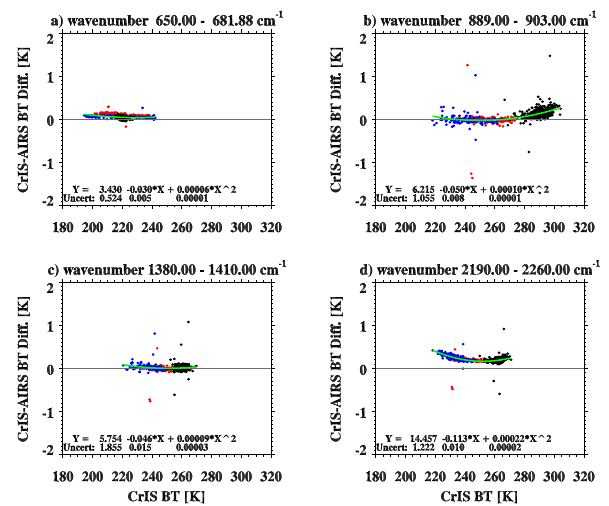
Figure 14. Scatter plots of CrIS–AIRS BT differences vs. CrIS BT at four spectral regions: (a) 650–681.88cm − 1 , (b) 889–903cm − 1 , (c) 1380.0–1410.00cm- 1 , and (d) 2190–2260cm − 1 . The red, blue, and black dots indicate the BT differences from north SNOs, south SNOs, and tropical SNOs. The quadratic regressions are shown in green. The regression results and their 1 σ uncertainties are also listed.